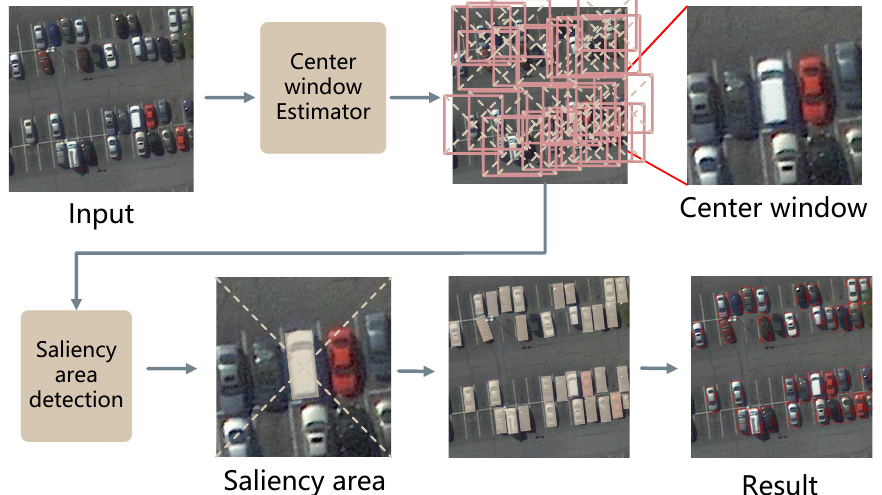
Figure 3. The pipeline of our algorithm. The center window estimator module obtains the center window of each vehicle. Then, the saliency region detection module detects the saliency region detection for each center window and decodes final predicted bboxes.